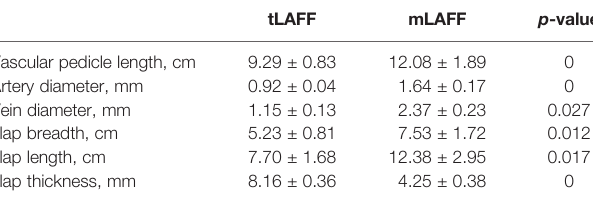
TABLE 2 | General characteristics of the fl